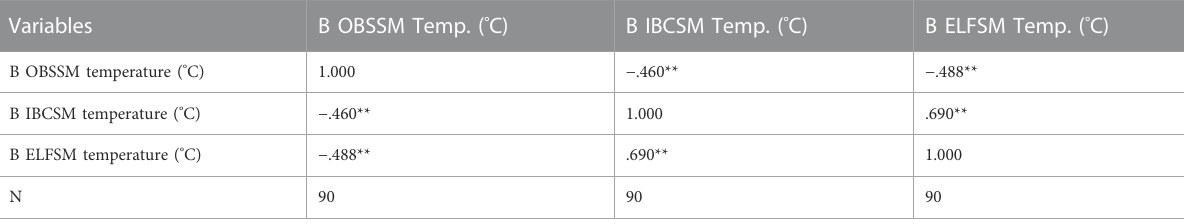
TABLE 8 Spearman ’ s bivariate rank correlations between the overall temperatures of B OBSSM, B IBCSM, and B ELFSM.